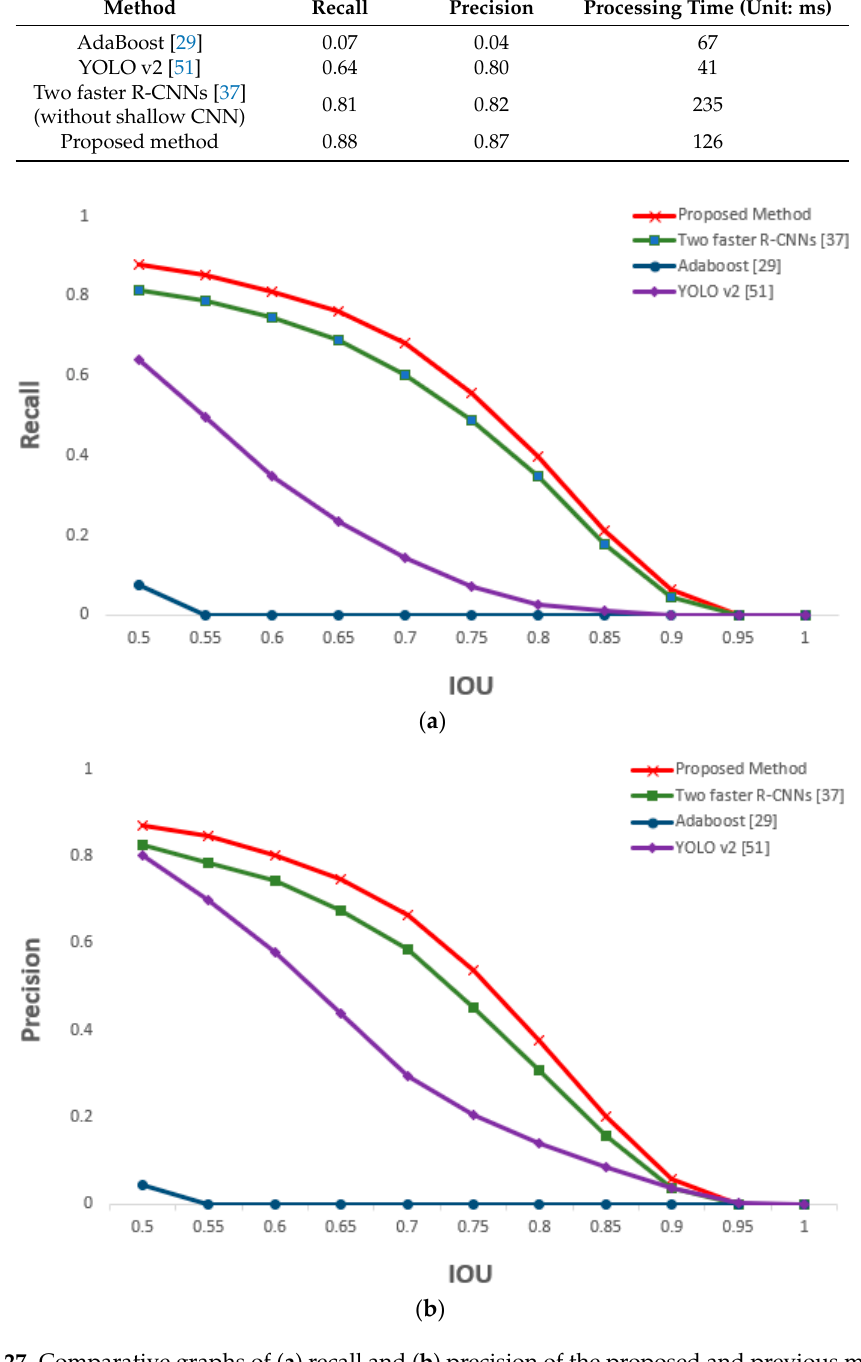
Figure 27. Comparative graphs of ( a ) recall and ( b ) precision of the proposed and previous methods according to IOU thresholds.